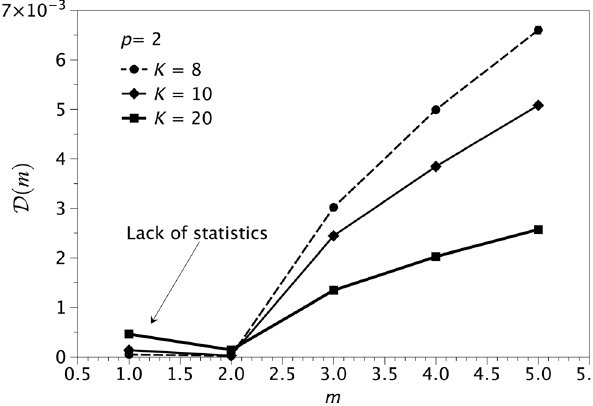
FIG. 13. Scenario 5b. Normalized Kullback-Leibler divergence D ð m Þ between X ð t Þ and its Markovianized surrogate Y ð t Þ for a two-layer multiplex where each layer has K nodes, and the second layer is a replica of the first layer, where p ¼ 2 shortcuts have been introduced.